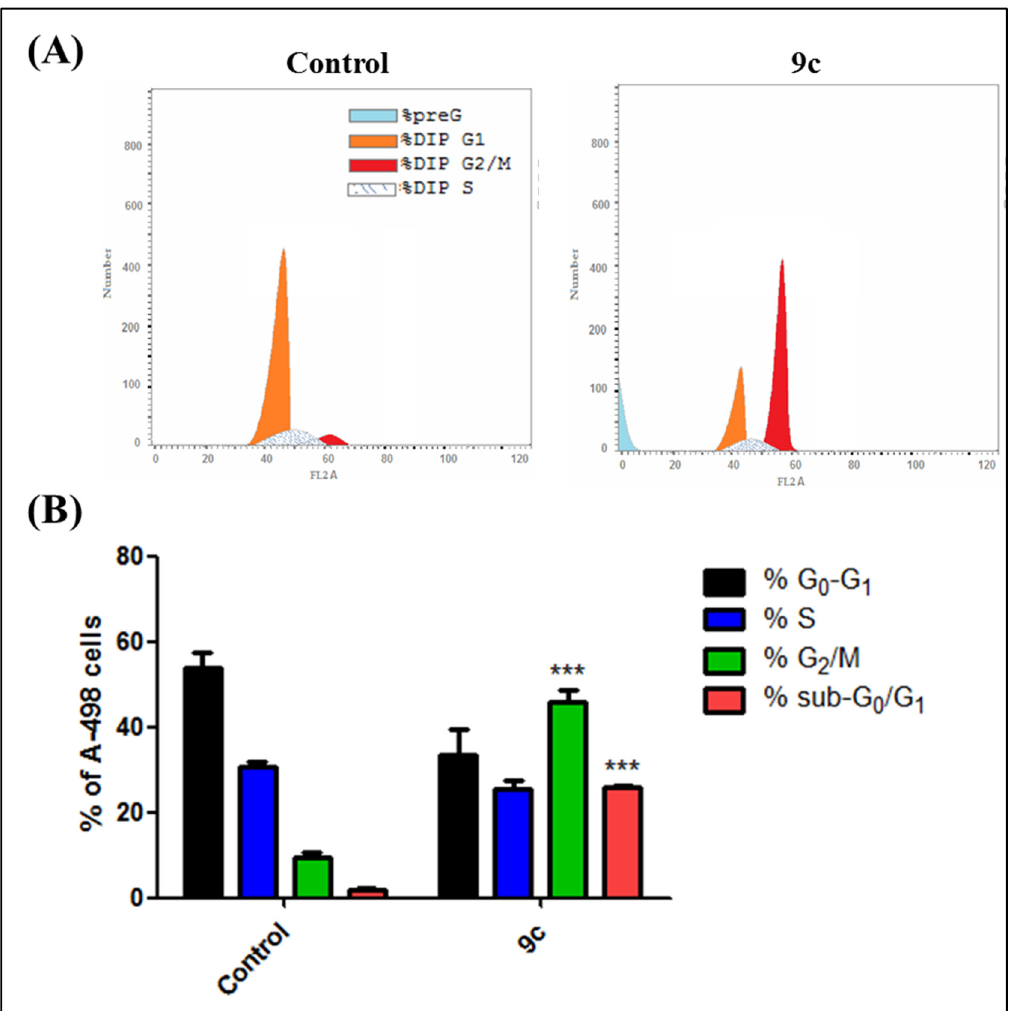
Figure 4. ( A ) E ff ect of compound 9c on the cell cycle and apoptosis in kidney carcinoma cell line A-498. Cells were treated with either vehicle [0.1% ethanol (v / v)], 9c (6 µ M; approximately IC 50 value) for 48 h. Cells were then fixed, stained with propidium iodide (PI), and analyzed by flow cytometry. Cell cycle analysis was performed on histograms of gated counts per DNA area (FL2-A). ( B ) Quantitative analysis of 4N (G2 / M), 2N (G0G1), > 2N (S), and < 2N (sub-G1). DNA content was determined with CellQuest software. Values represent the mean ± SEM for three independent experiments. Statistical analysis was performed using one-way ANOVA-Bonferroni post-hoc test (***, p <